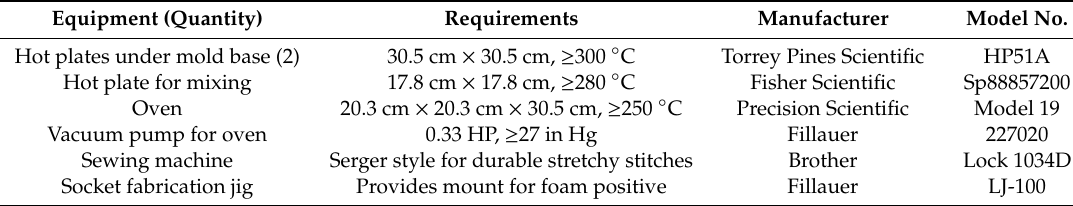
Table A1. Equipment and supplies used for